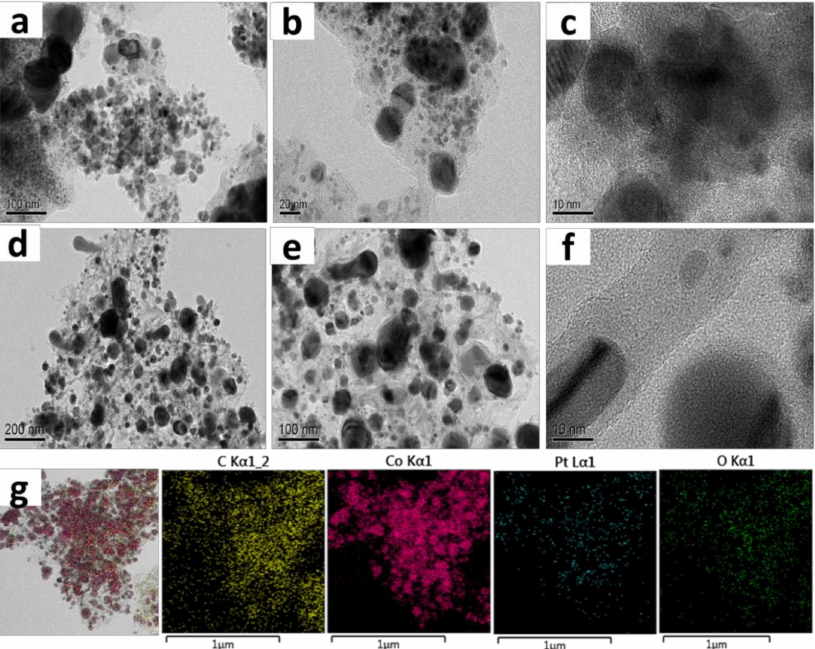
Figure 14. TEM analysis of Co/C ( a – c ) and of Pt@Co/C(10:1:2.4) ( d – f ) after the catalytic process, and ( g ) the STEM elemental distribution in